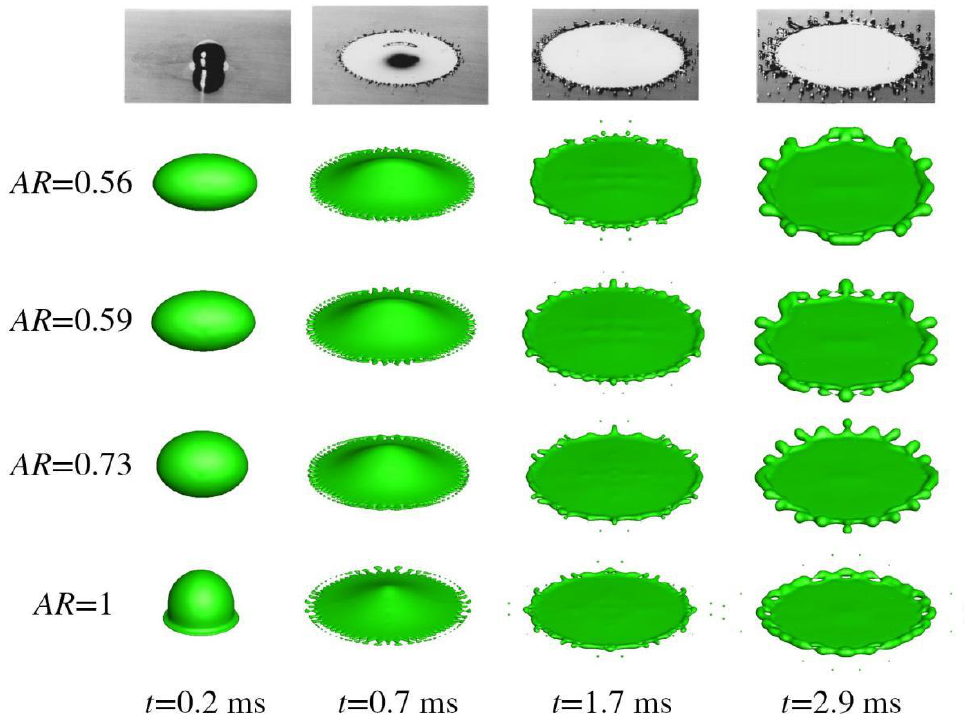
Figure 11. Oblate Tin droplet impingement with a 90° impacting angle.